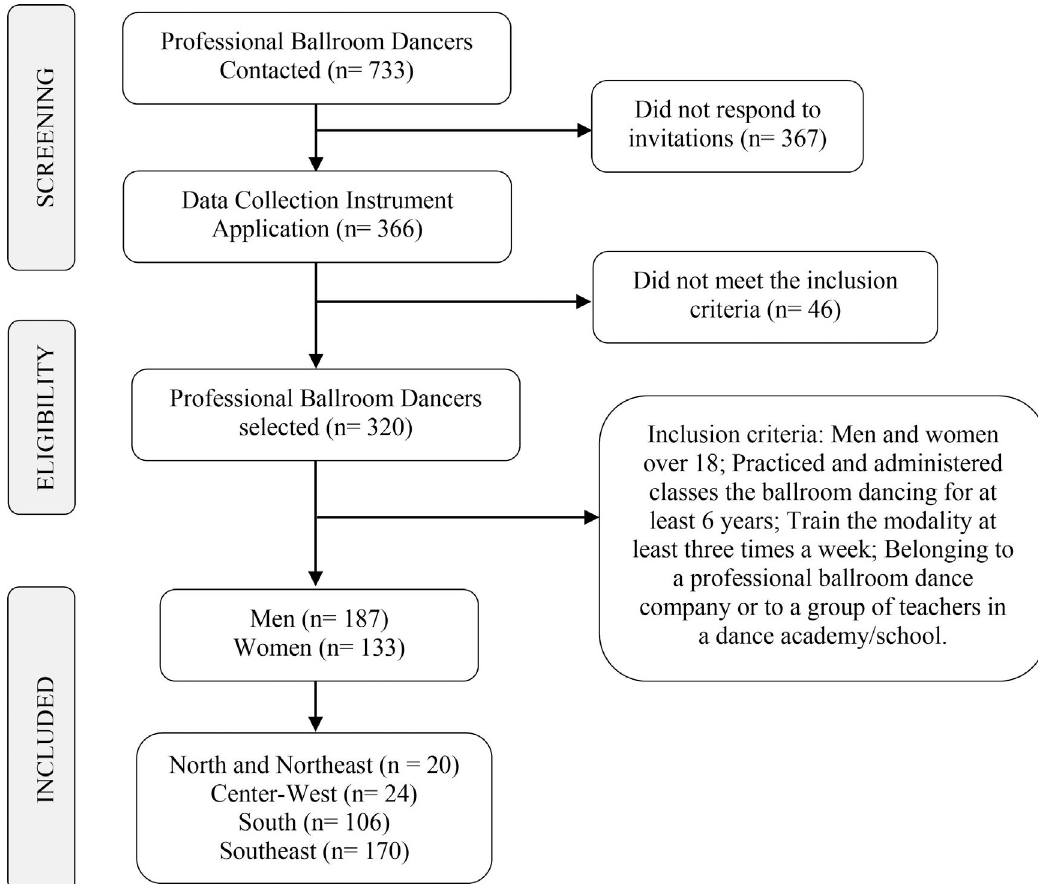
Figure 1 - Flowchart